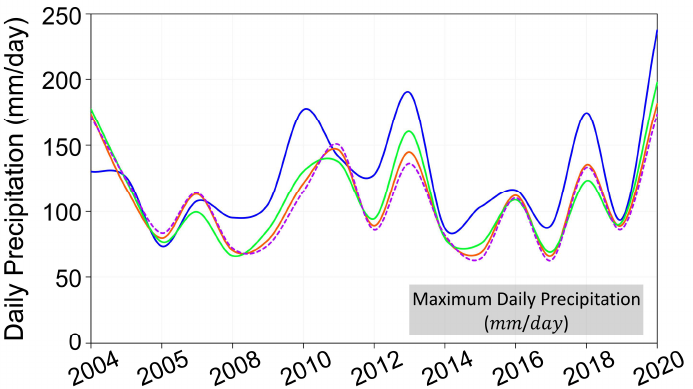
Figure 8. Maximum daily precipitation per year based on the NN-, IDW-, RBF-, and OK-based areal precipitations.